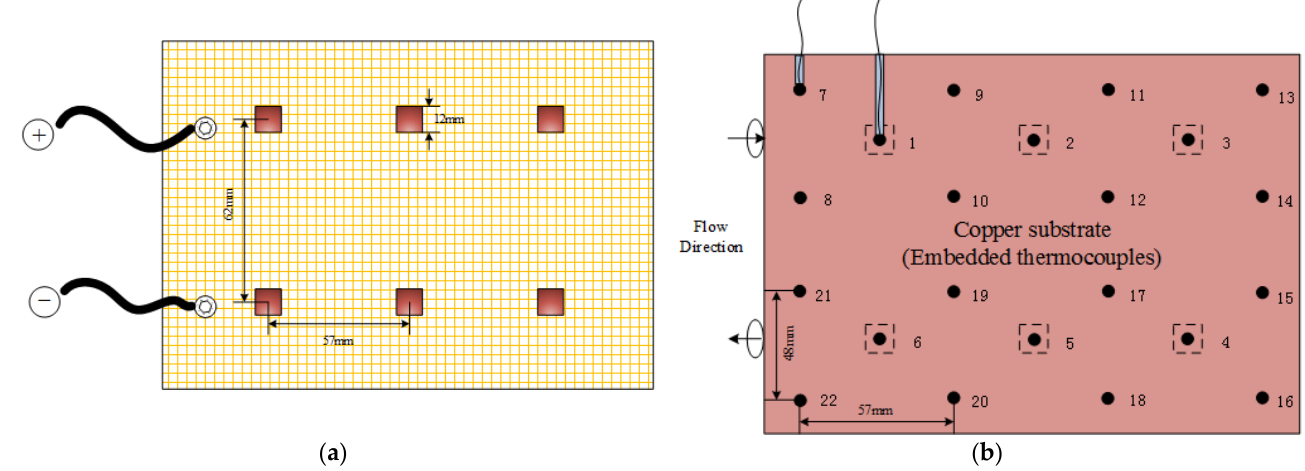
Figure 6. ( a ) Schematic diagram of the IGBT equivalent heat generator ( b ) Thermocouple ar-